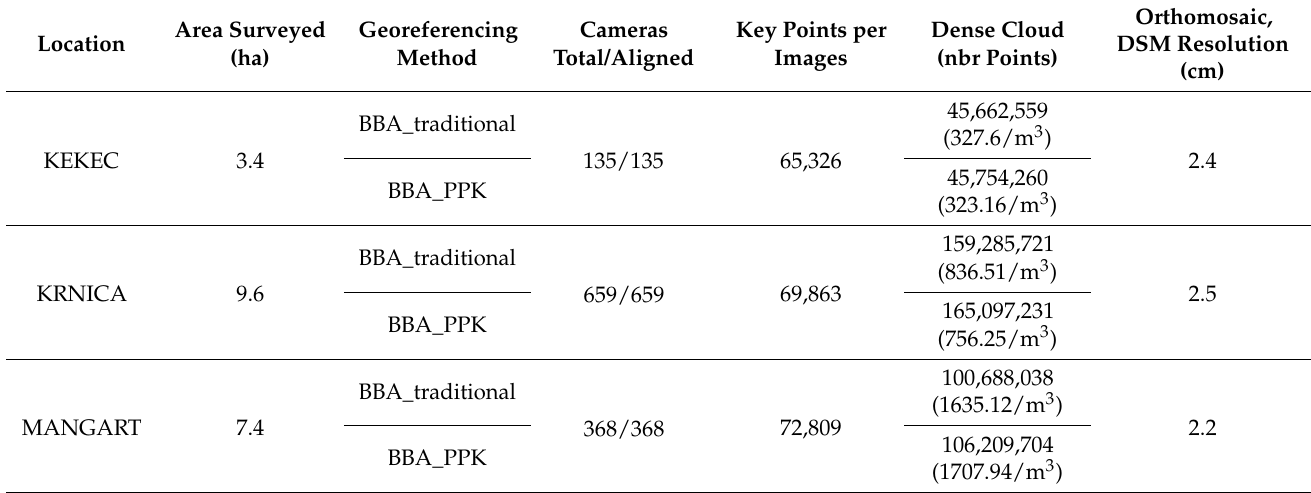
Table 1. Results of photogrammetric processing provided by the Pix4D software for different locations and georeferencing methods.